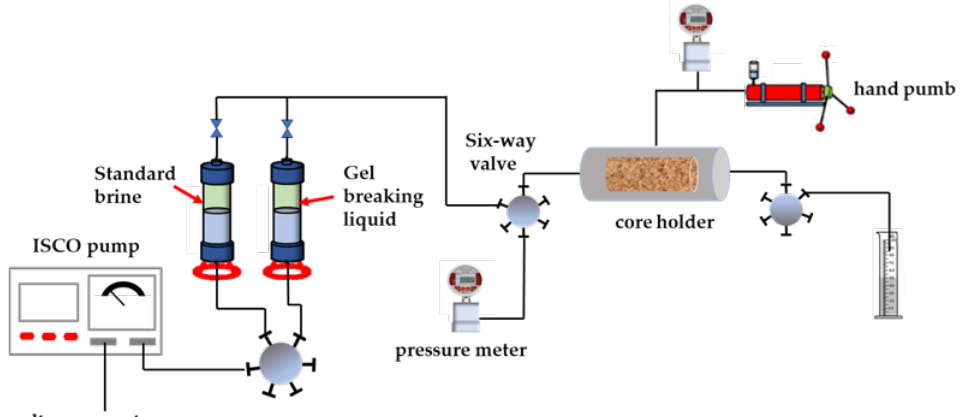
Figure 15. Core permeability damage test device.